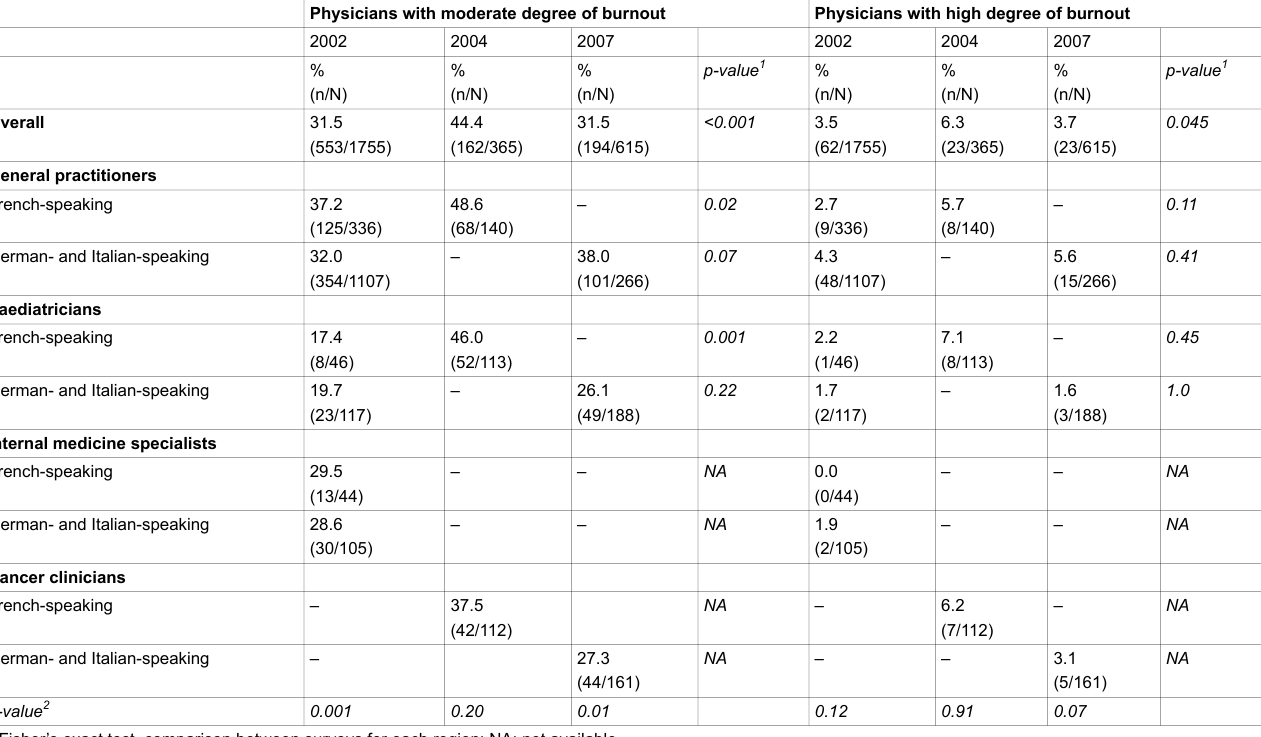
Table 2 Distribution of burnout among 2735 Swiss general practitioners, paediatricians, internal medicine specialists and cancer clinicians across different regions of the country in 2002, 2004 and